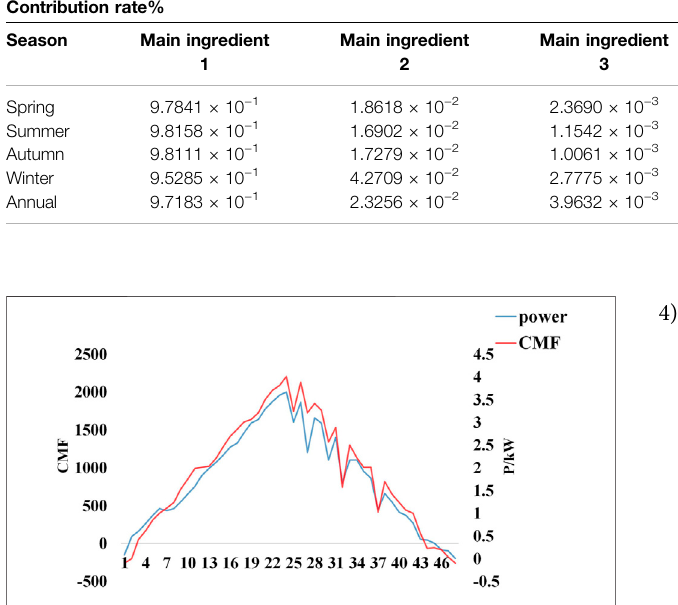
TABLE 2 | Results of PCA.